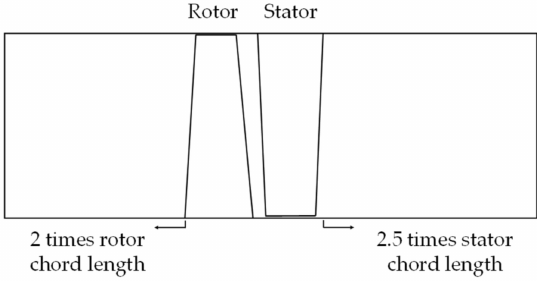
Figure 1. The meridian view of the research compressor. Table 1. Geometric parameters of the research